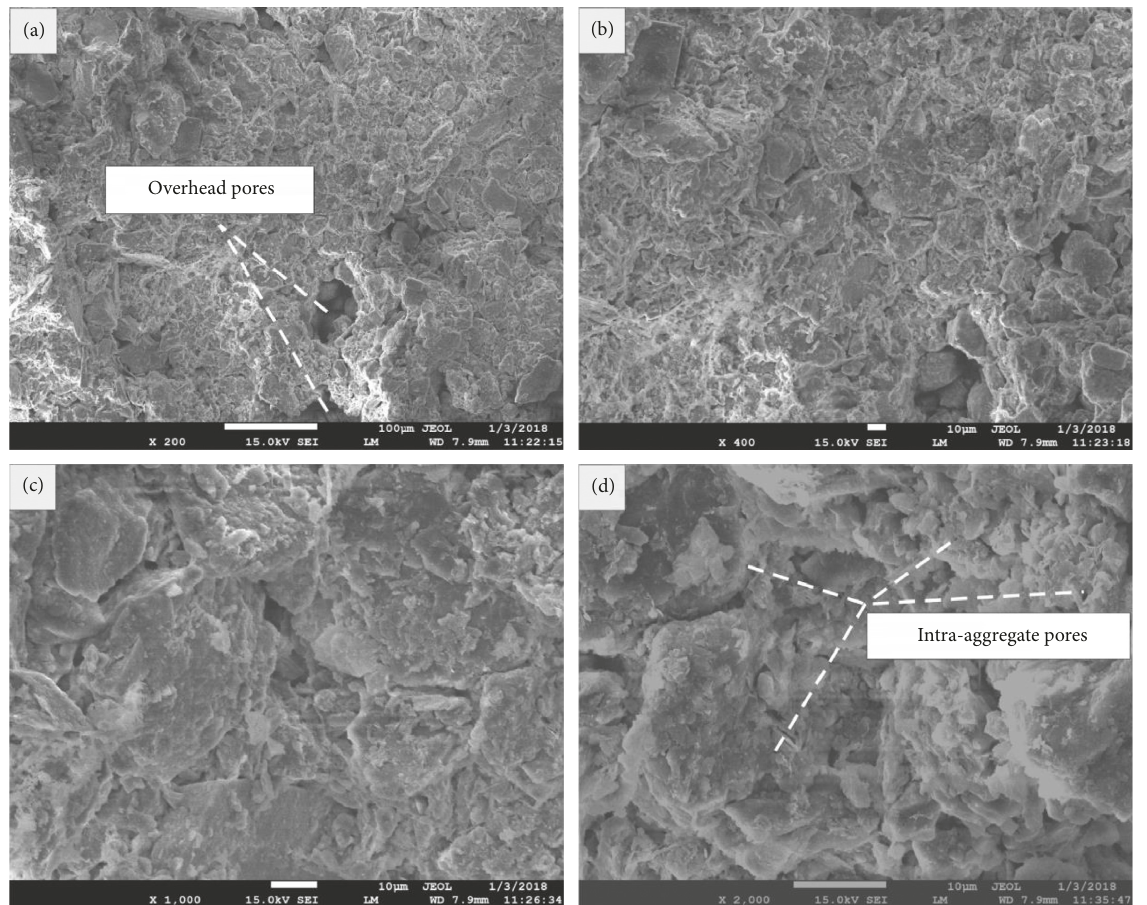
Figure 7: SEM photographs of loess compacted at wet of optimum under different magnification: (a), (b), (c), and (d) are under magnification of 200, 400, 1000, and 2000, respectively.